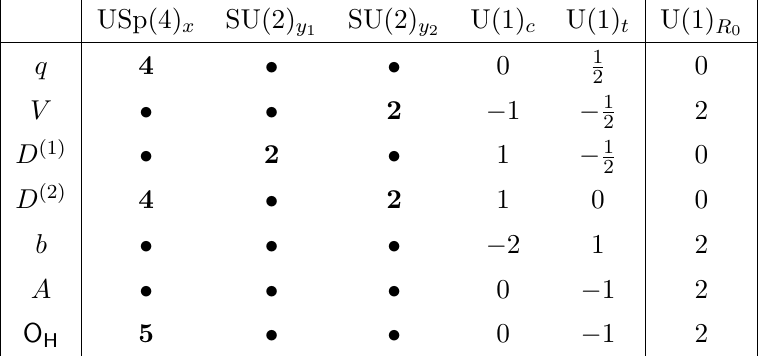
Table 3 . Transformation rules under the global symmetries and the trial R-symmetry U(1) R all the chiral fields of the